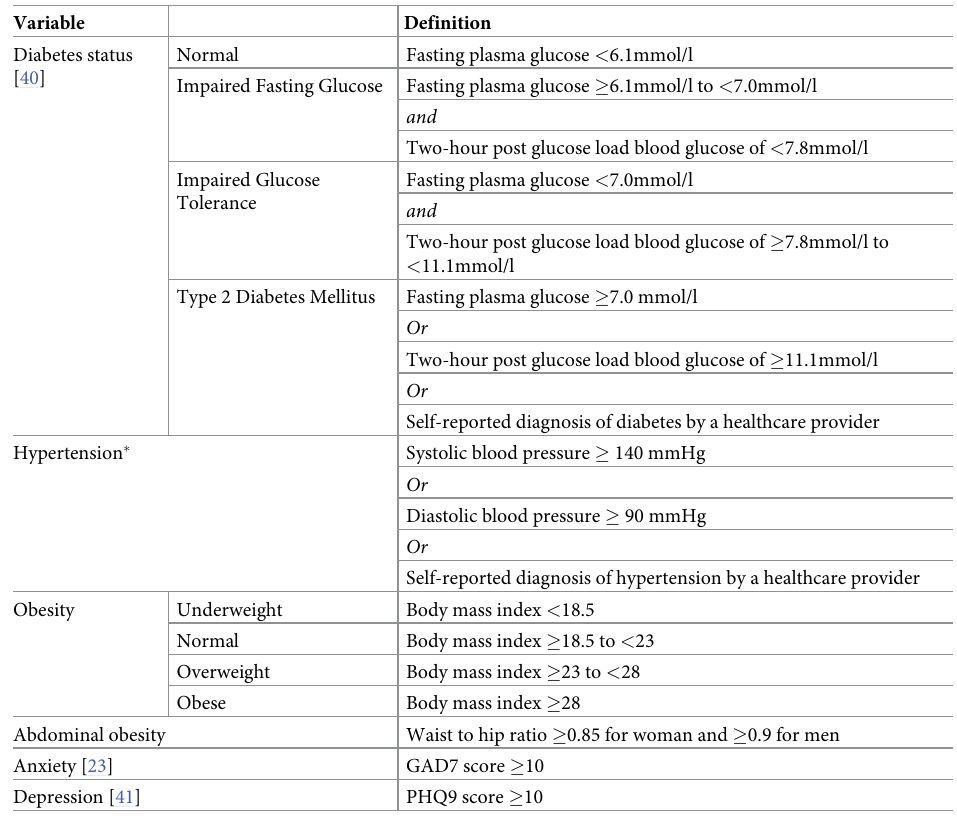
Table 1. Definitions for anthropometric